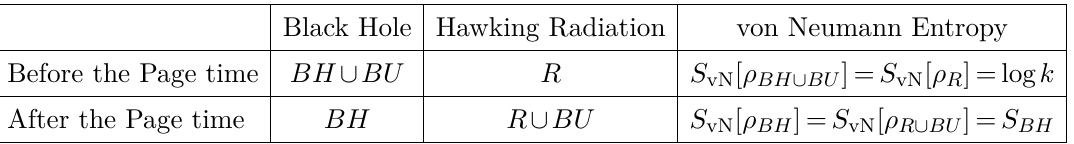
Table 1 . How to divide the total system BH ∪ R ∪ BU into two sub systems before and after the Page time, and the corresponding von Neumann